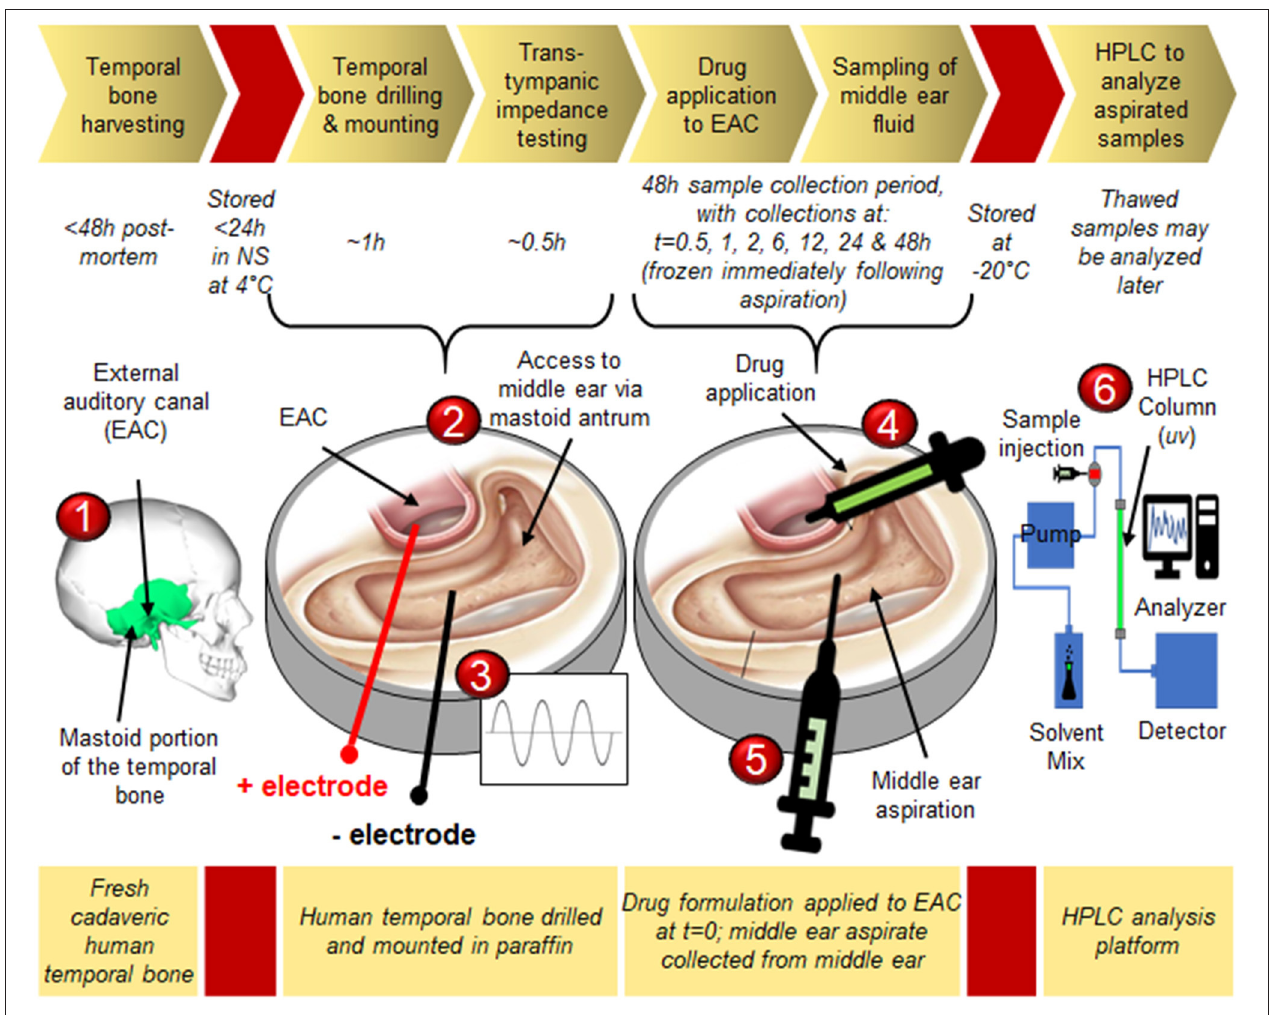
FIGURE 1 | Experimental timeline for measurement of trans-tympanic drug delivery in situ : 1) Cadaveric temporal bones are collected from the Mass Eye and Ear otopathology service; 2) The mastoid portion of the temporal bone is carefully drilled away under a microscope to expose the middle ear space via the antrum and facial recess, and the drilled bone is mounted in paraffin to provide access to both the external auditory canal (EAC) as well as the middle ear space; 3) Impedance testing confirms intactness of the tympanic membrane; 4) The middle ear is loaded with phosphate-buffered saline (PBS), while drug is applied to the lateral surface of the tympanic membrane via the EAC; 5) At defined time points the middle ear fluid is aspirated and replaced with fresh PBS; 6) Aspirated samples are analyzed via high performance liquid chromatography to determine drug concentration with high degree of precision. Graphical representation of temporal bone seen in steps 2–5 is adapted from Jackler (15) (c) Chris Gralapp